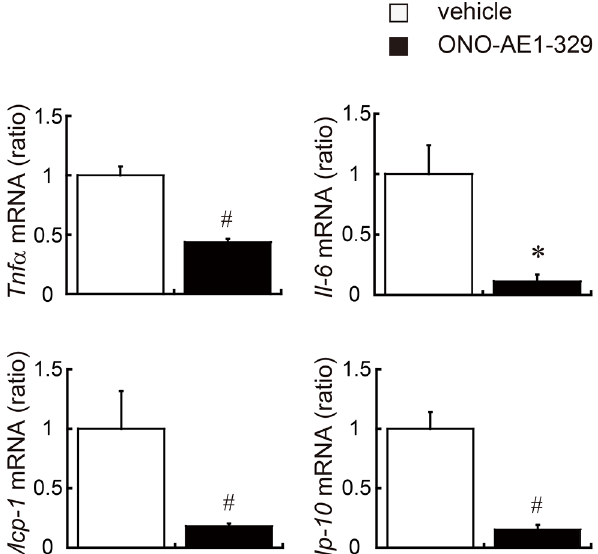
Fig 3. Cytokine and chemokine gene expression in SVF. Relative expression of Tnf α , Il-6 , Mcp-1 , and Ip- 10 mRNA in SVF isolated from db/db mice administered EP4 agonist (black bar) or vehicle (white bar). All values are mean ± SEM (n = 3 each). * p < 0.05; ] p < 0.01 vs. vehicle. SVF, stromal vascular fraction; Tnf α , tumor necrosis factor α ; Il-6, interleukin-6; Mcp-1, monocyte chemotactic protein-1; Ip-10, interferon gamma – induced protein